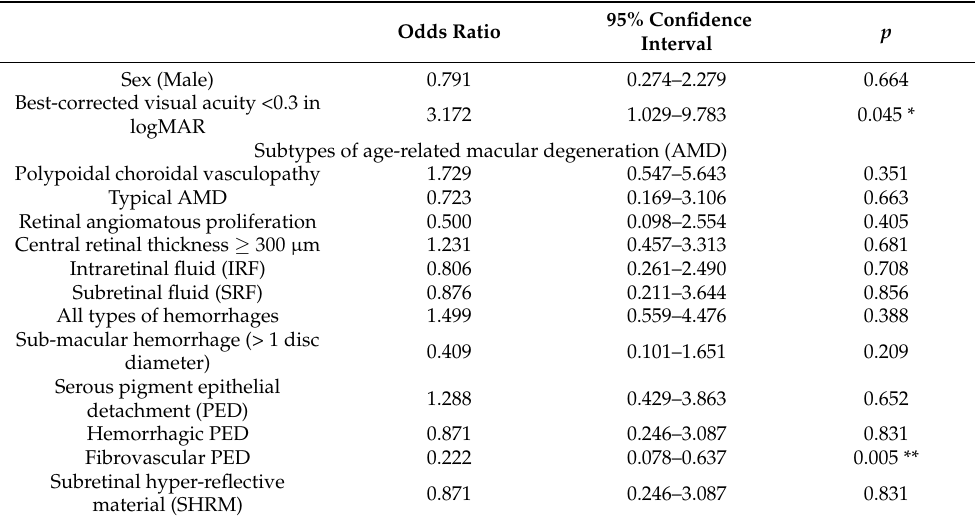
Table 2. Predictive factors for maintained or improved best-corrected visual acuity at the last visit, after adjusting for age.